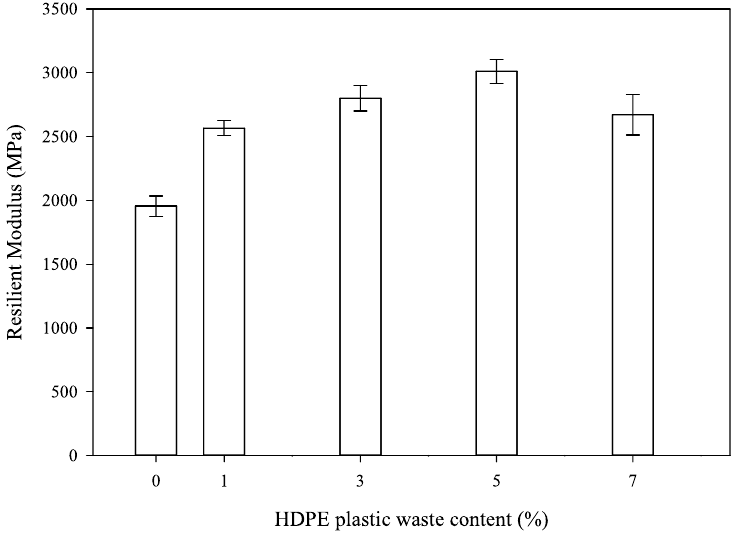
Figure 4. Resilient modulus of HDPE-ACP.